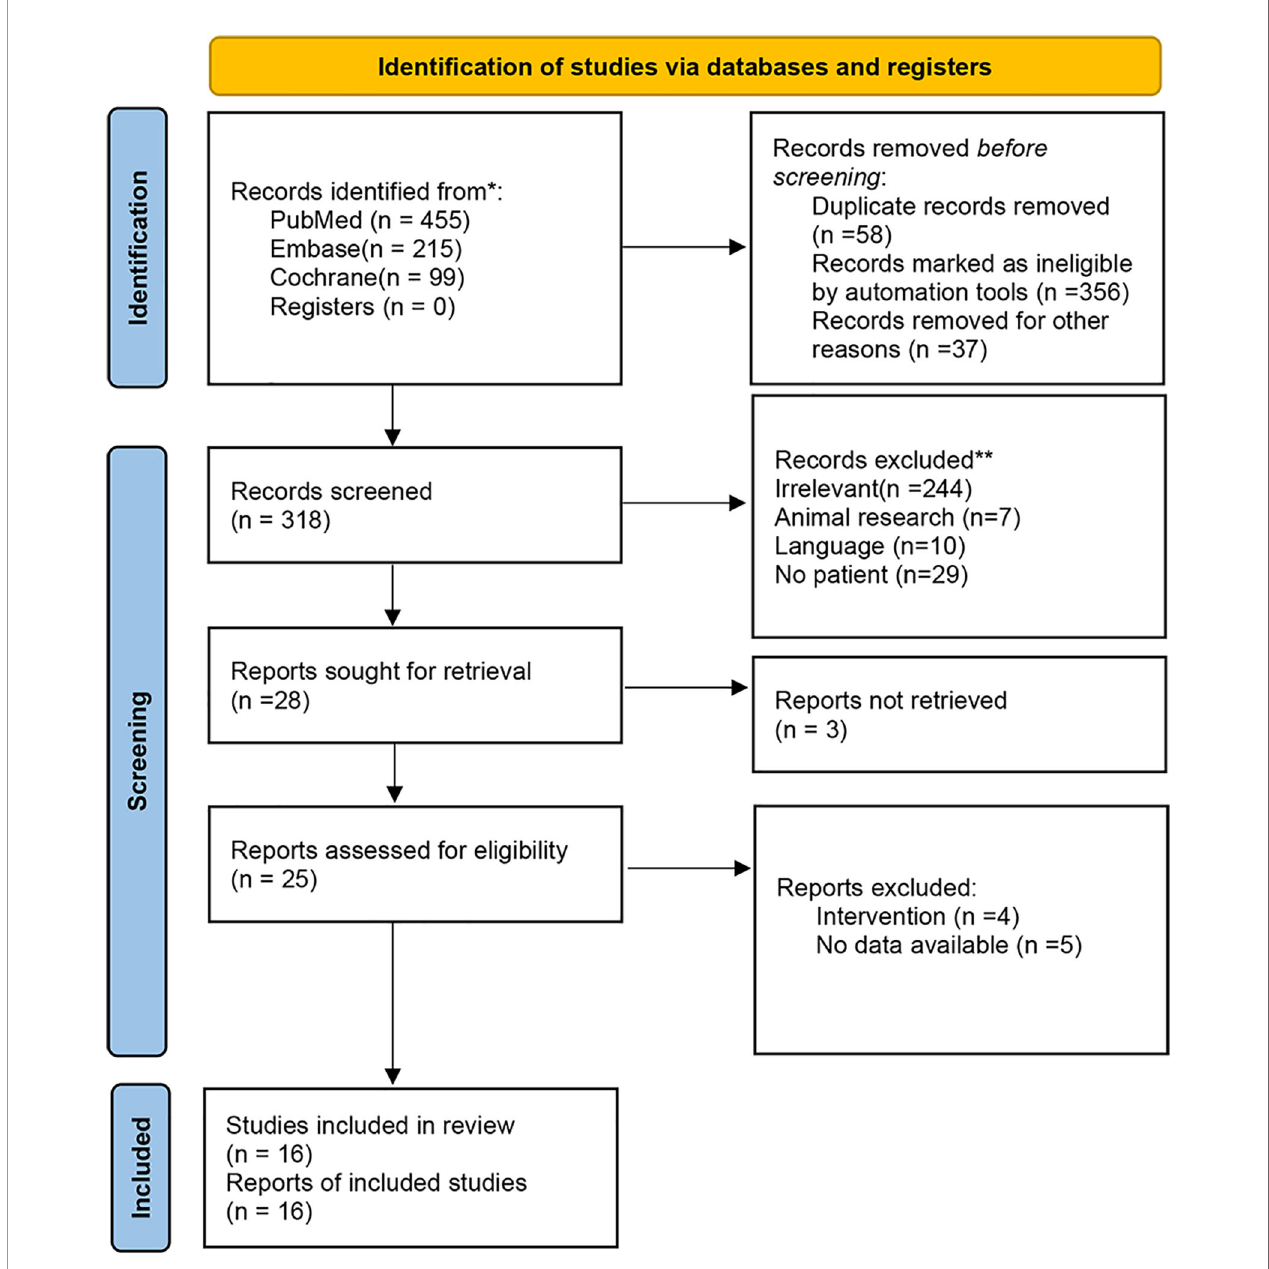
FIGURE 1 | Consort chart of the included/excluded